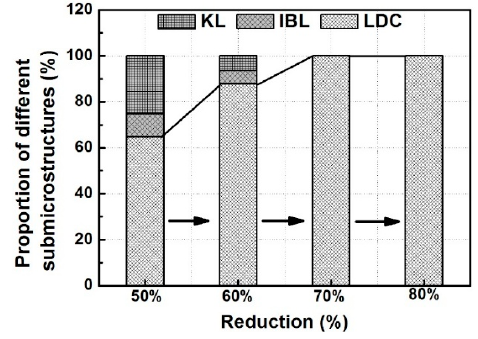
Figure 5. Percentage of different substructures at different reduction amounts.